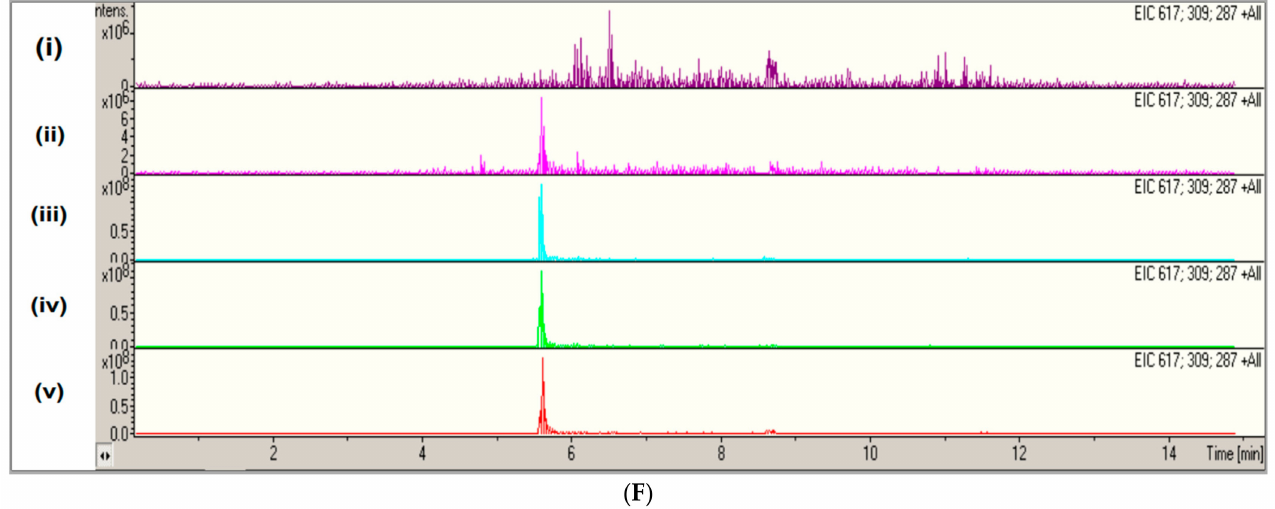
Figure 4. ( A ) Standard curve of labelled EGT. Standard curve generated using 9 EGT standards rang- ing from 0.08 to 20.83 µ g/mL of EGT loaded onto column. Accuracy of standards was assessed by the R 2 value = 0.9998 indicating a high degree of accuracy; ( B ) quantification of EGT production. Quantity of EGT in BY474 -egtA grown in SC media: 1 = quantity of intracellular (IC) EGT (10.12 µ g/L) after 24 h; 2 = quantity of extracellular (EX) EGT (1.91 mg/L) after 24 h, and at significantly **** ( p ≤ 0.0001) higher amounts; 3 = quantity of extracellular EGT (4.89 mg/L) after 48 h; 4 = quantity of extracellular EGT (6.07 mg/L) after 72 h; 5 = quantity of extracellular EGT (7.93 mg/L) after 96 h; 6 = quantity of extracellular EGT (7.53 mg/L) after 120 h; ( C ) L-Met availability influences EGT production in recom- binant S. cerevisiae . Amount of secreted EGT produced per weight of cells ( µ g/g) in BY4741 egtA-His supernatants grown at a range of L-Met concentrations. Cultures grown at 0.134 mM L-Met show a significant * ( p < 0.05) increase in EGT produced per gram of cells versus cultures grown at all other concentrations of L-Met; ( D , E ) EGT is released from immobilised recombinant S. cerevisiae –EgtA at 24 h and at significantly *** ( p < 0.001) higher amounts at 48 h; ( F ) stacked EIC chromatograms following LC–MS analysis of ( i ) negative control, ( ii ) positive control (EGT (5 µ g/mL), ( iii ) sample number 1 ( iv ) sample number 4, and ( v ) sample number 6. The peak visible at RT 5.6 min in samples ( ii )–( v ), inclusive, is